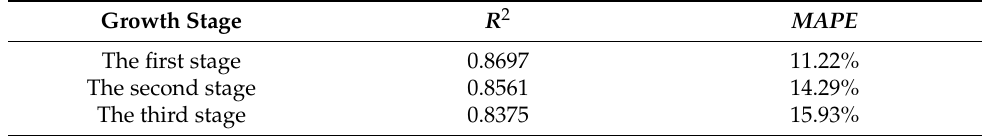
Table 14. R 2 and MAPE for the linear regression dry weight model. Table 14. 𝑅 2 and 𝑀𝐴𝑃𝐸 for the linear regression dry weight model.